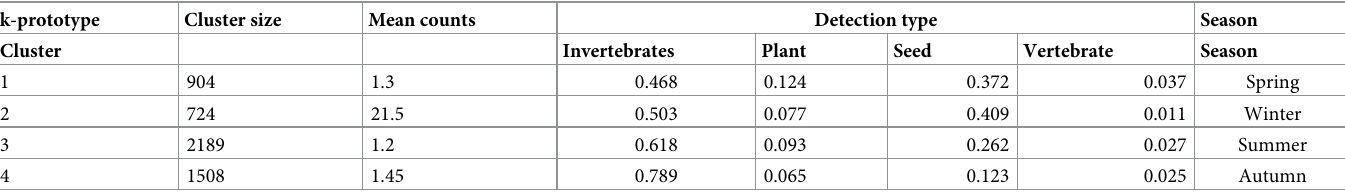
Table 5. Clustering using both numeric and categorical variables using data from Barrow Island between 2009 and 2015. k-prototype